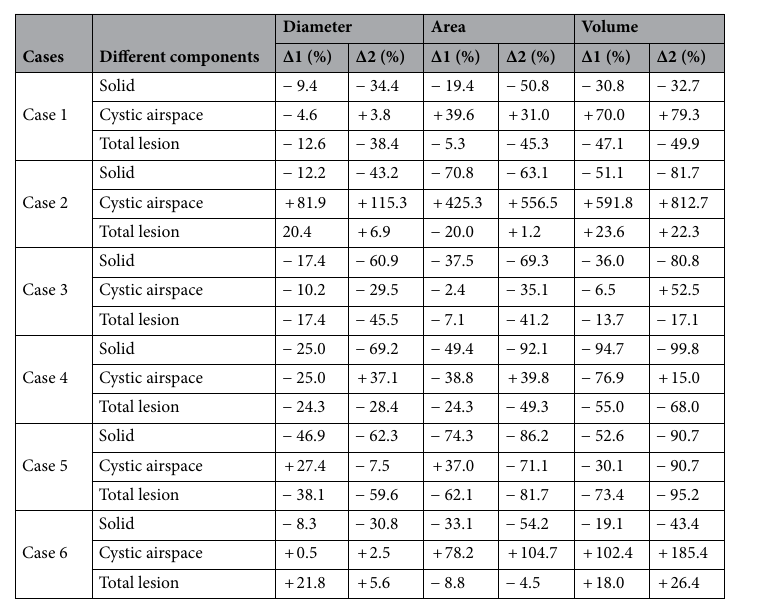
First Time − Baseline